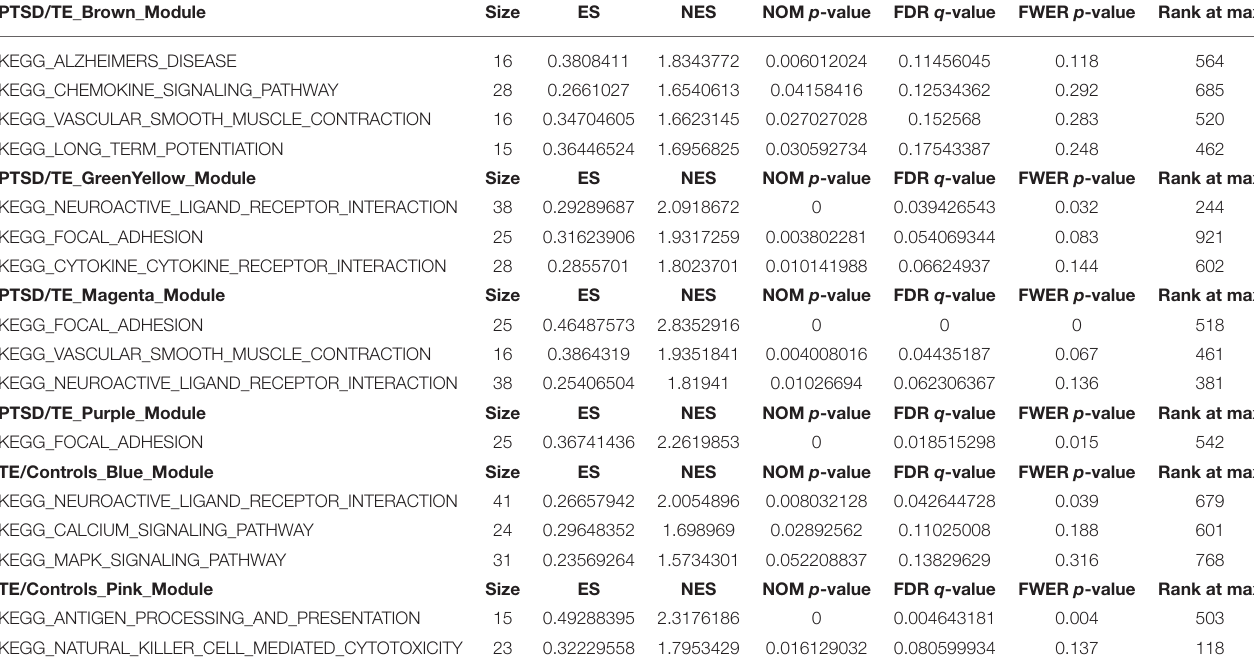
TABLE 3 | GSEA ontology enrichment results for the significant gene